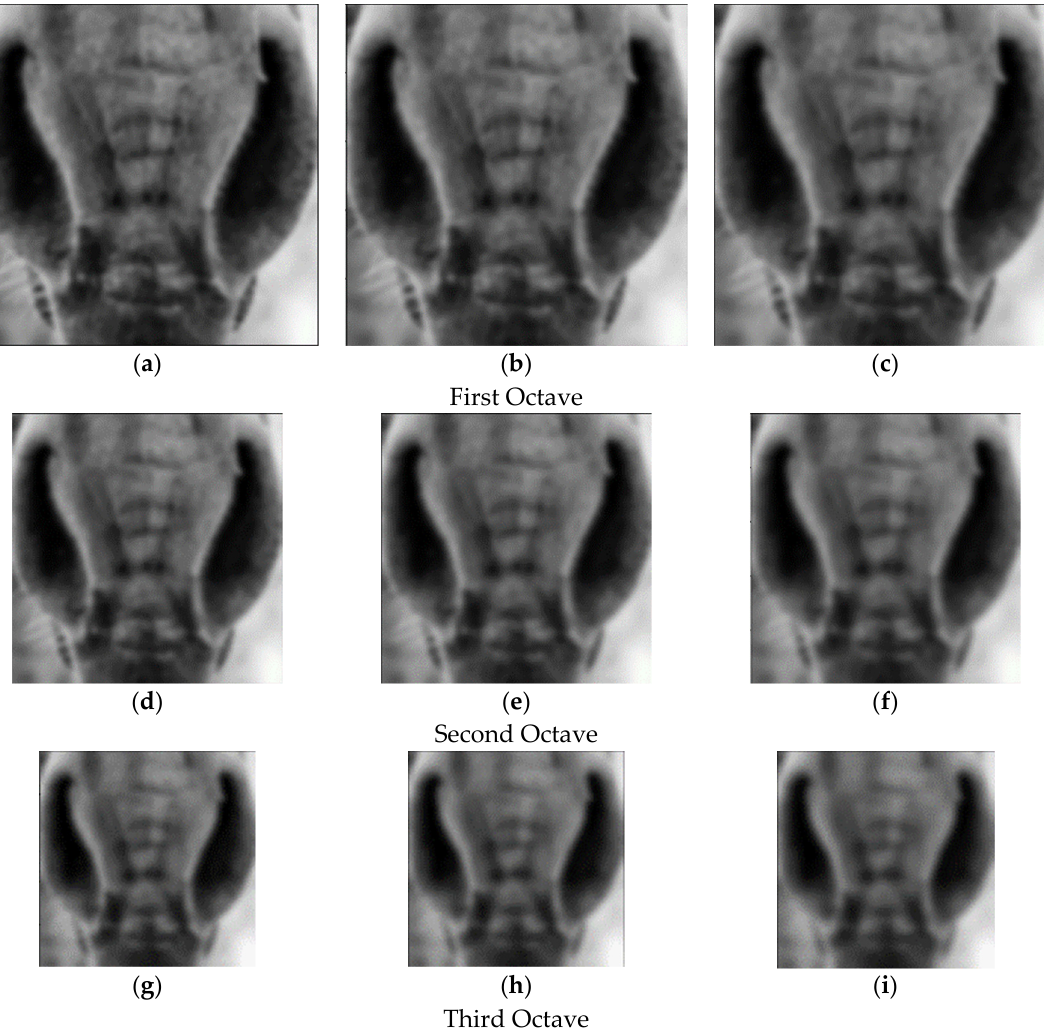
Figure 9. Scale-space generation using scale-invariant feature transform algorithm.